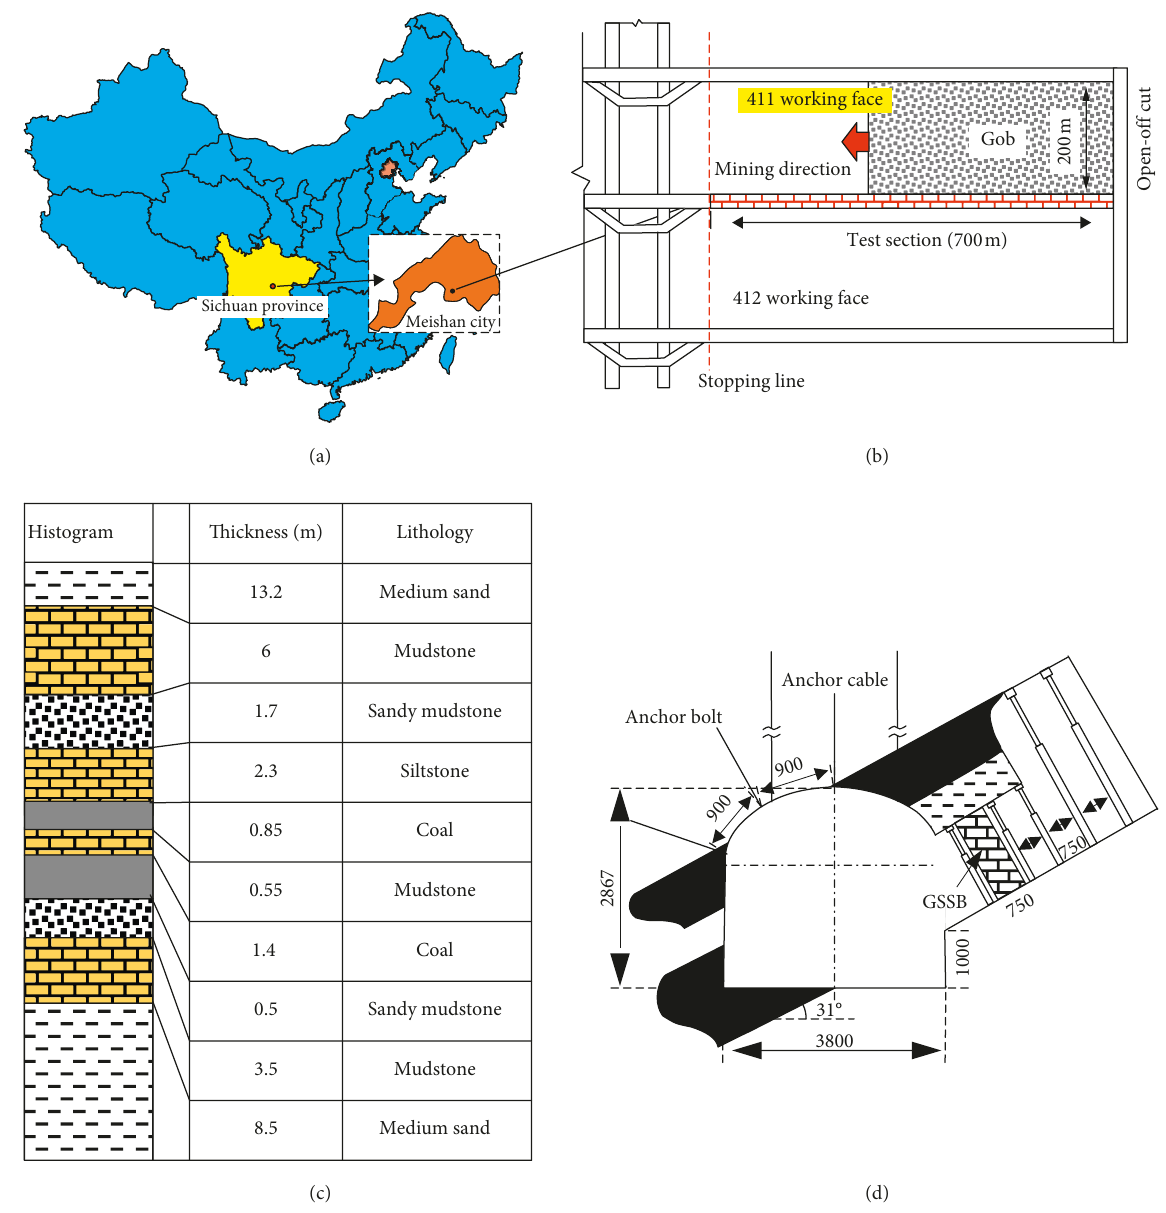
Figure 1: Engineering conditions. (a) Geographical situation, (b) working face layout, (c) geological column of working face, and (d) retained roadway support